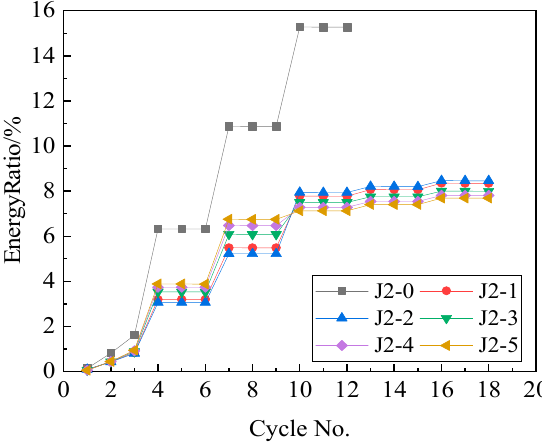
Figure 23. Energy dissipation ratio–cycle no. curves.